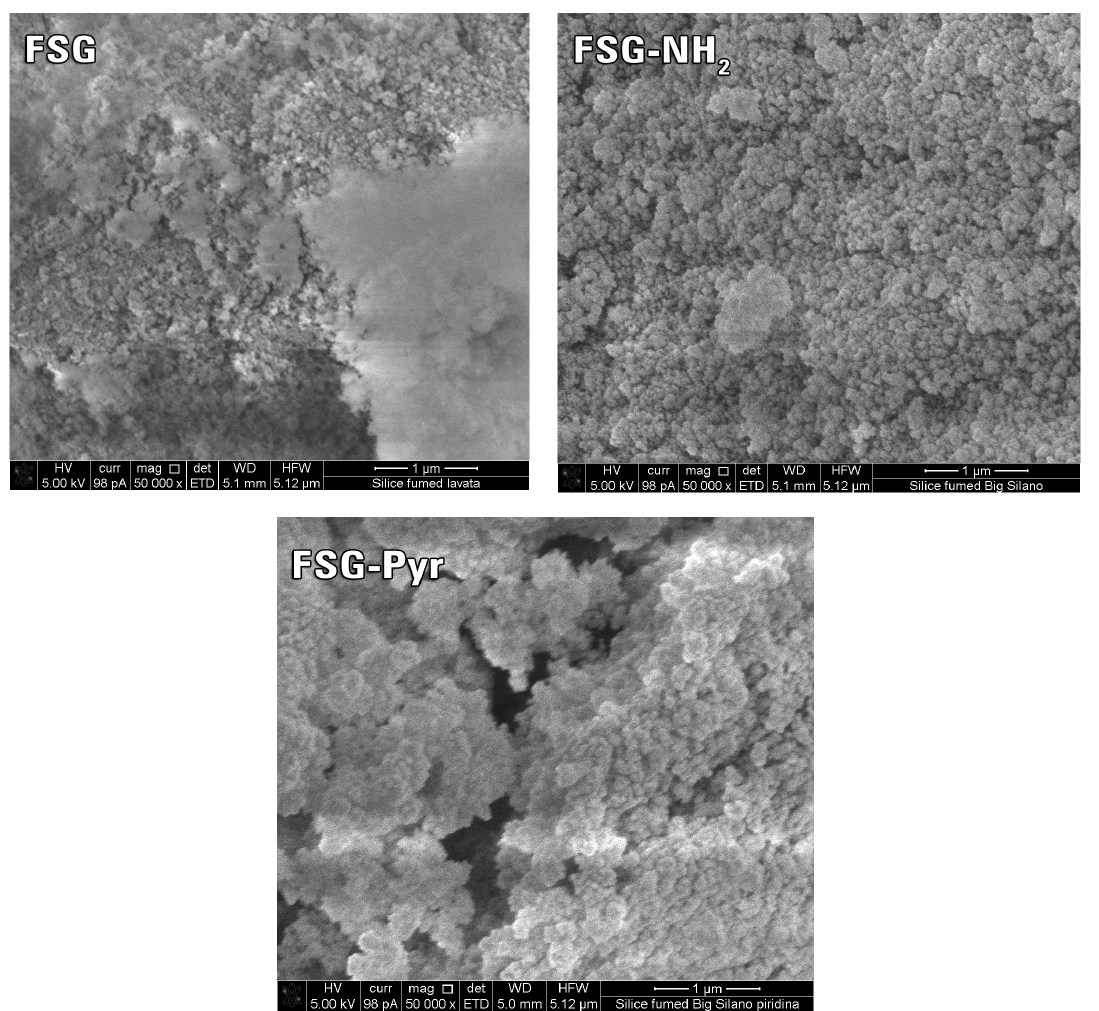
Figure 6 . SEM images of FSG, FSG-NH2, and FSG-Pyr. Figure 6. SEM images of FSG, FSG-NH2, and